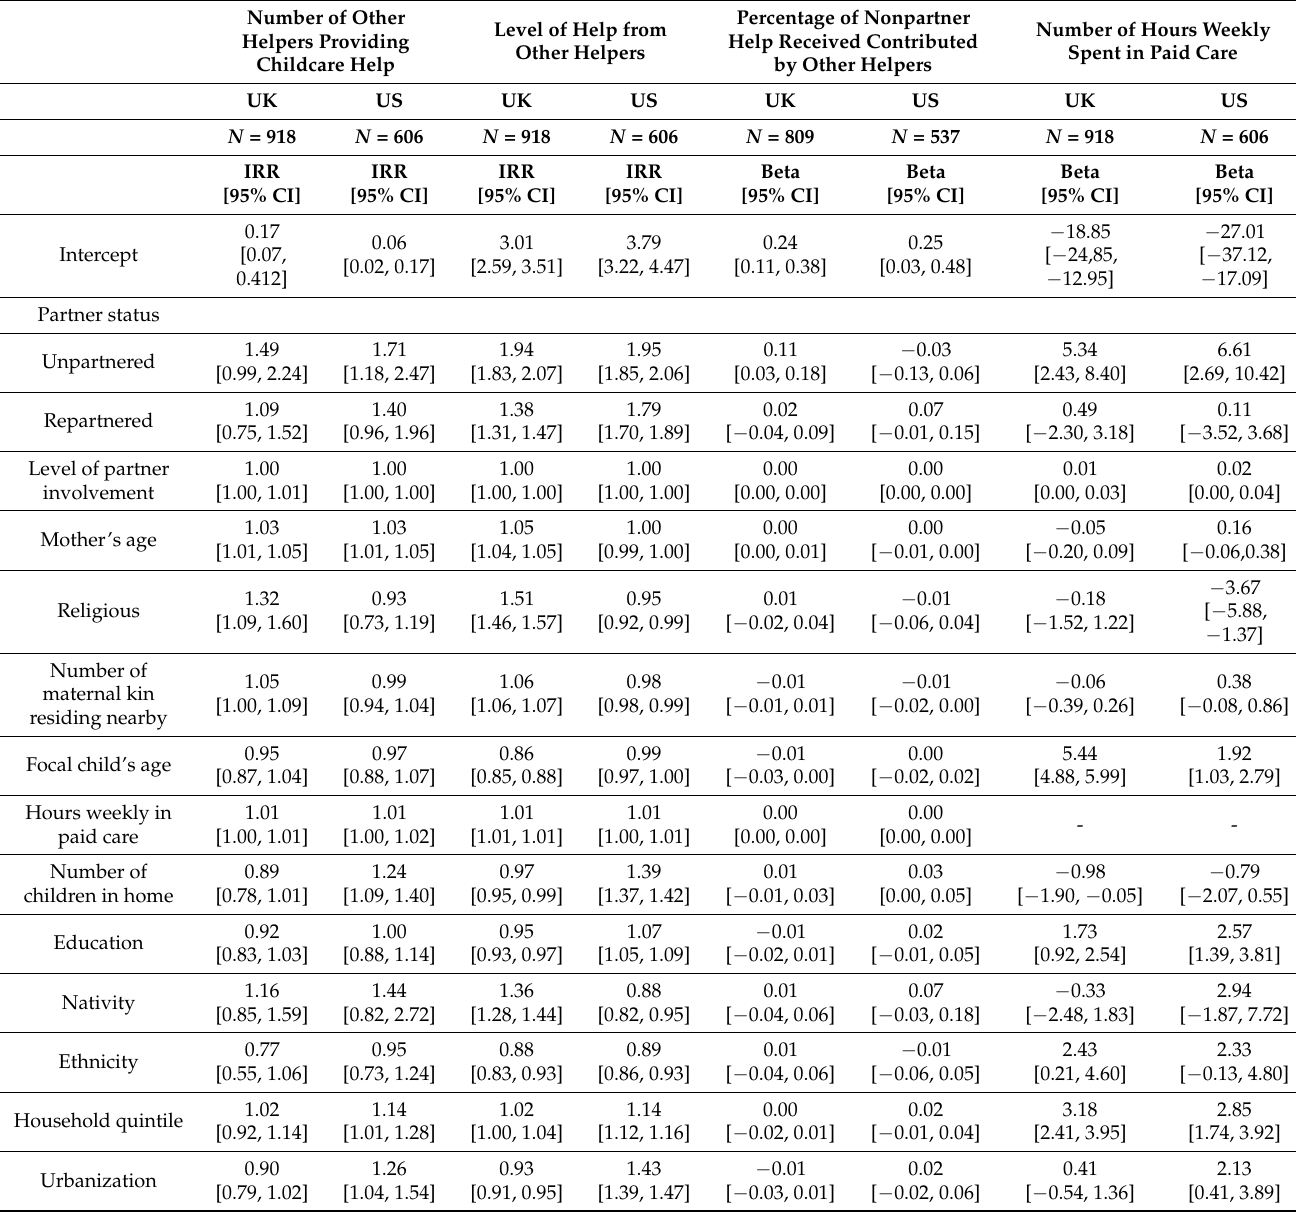
patterns in reliance on other allomothers were inconsistent across countries. Unpartnered women relied more on other allomothers than did partnered women in the UK (Beta [95% CI] = 0.11 [0.03, 0.18], but there was no difference in reliance on other allomothers between unpartnered and partnered women in the US (Beta [95% CI] = − 0.03 [ − 0.13, 0.06]). Similarly, repartnered women relied on other allomothers more than did partnered women in the US (Beta [95% CI] = 0.07 [ − 0.01, 0.15]), although the effect was unclear, but no difference in reliance on other allomothers was found in the UK (Beta [95% CI] = 0.02 [ − 0.04, 0.09]). Table 4. Results of Bayesian regression models predicting childcare involvement of other (nonpartner, nonmaternal kin) allomothers and reliance on paid care in the US and in the UK. Number of Other Percentage of Nonpartner Level of Help from Number of Hours Weekly Helpers Providing Help Received Contributed Other Helpers Spent in Paid Childcare Help by Other Helpers